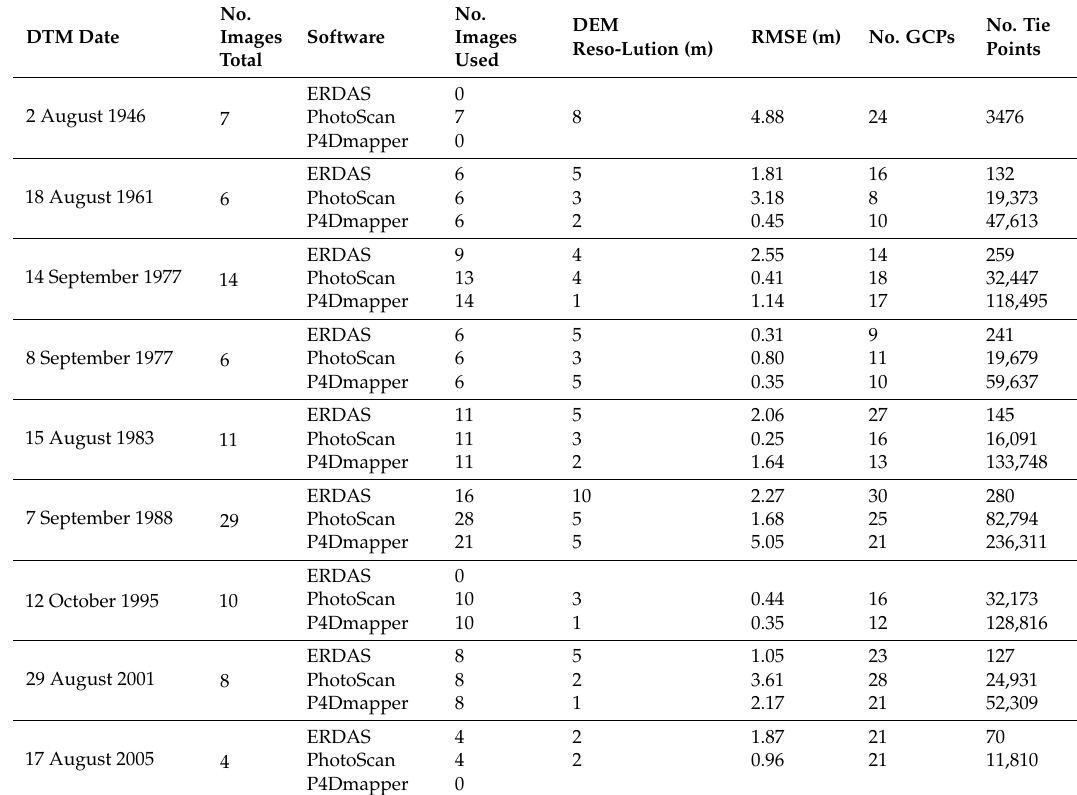
Table 2. Resulting DTMs for each